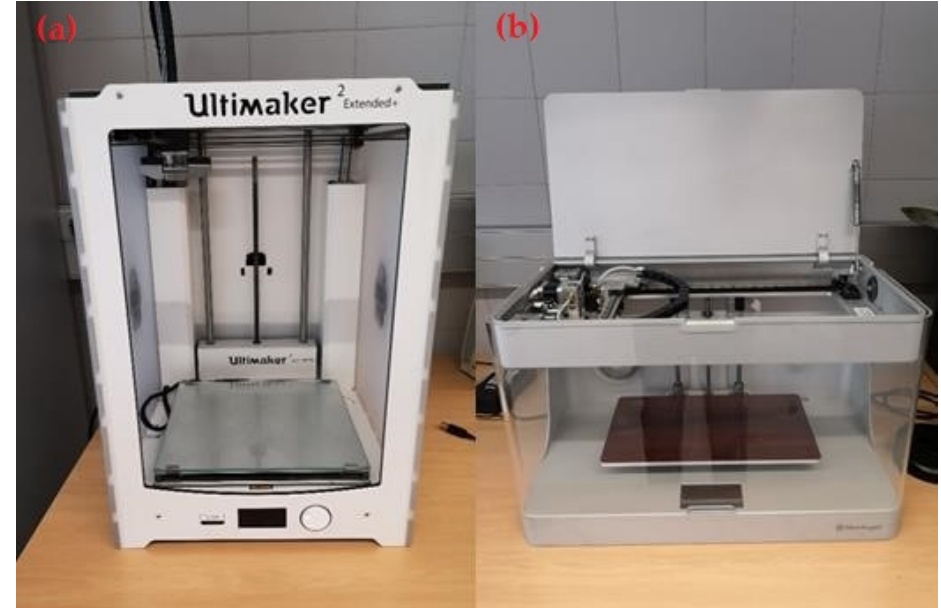
Figure 2. ( a ) Ultimaker 2 Extended+ printer; ( b ) Markforged Mark Two printer.